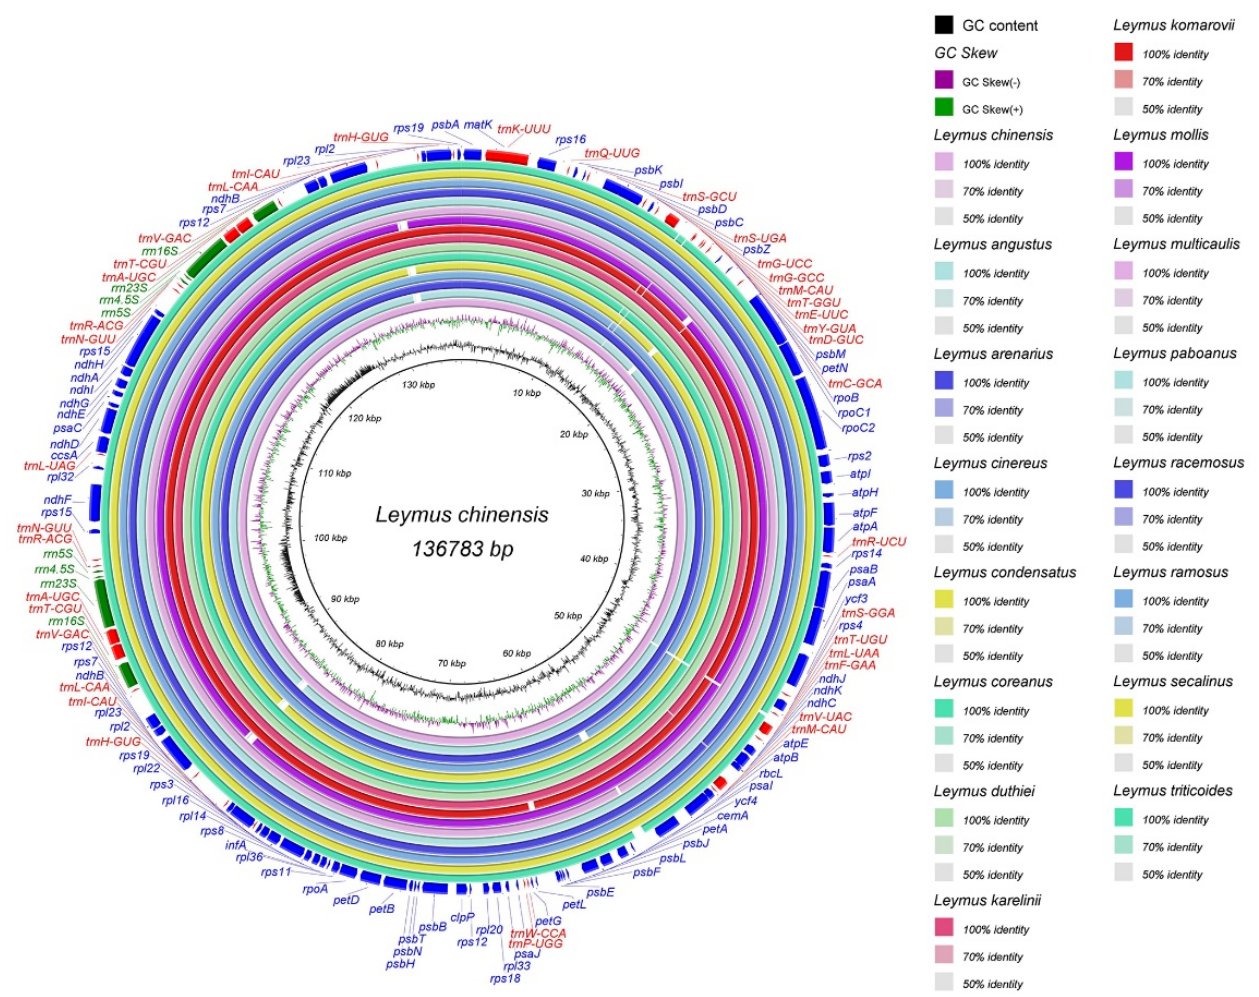
Figure 4. Sequence identity of the 16 Leymus species. The outermost circle represents the correspondence of protein-coding genes and intergenic spacer regions, and the innermost circle represents the L. chinensis genome as a reference. Other circles represent the output of the sequence identity analysis of the 15 Leymus species.